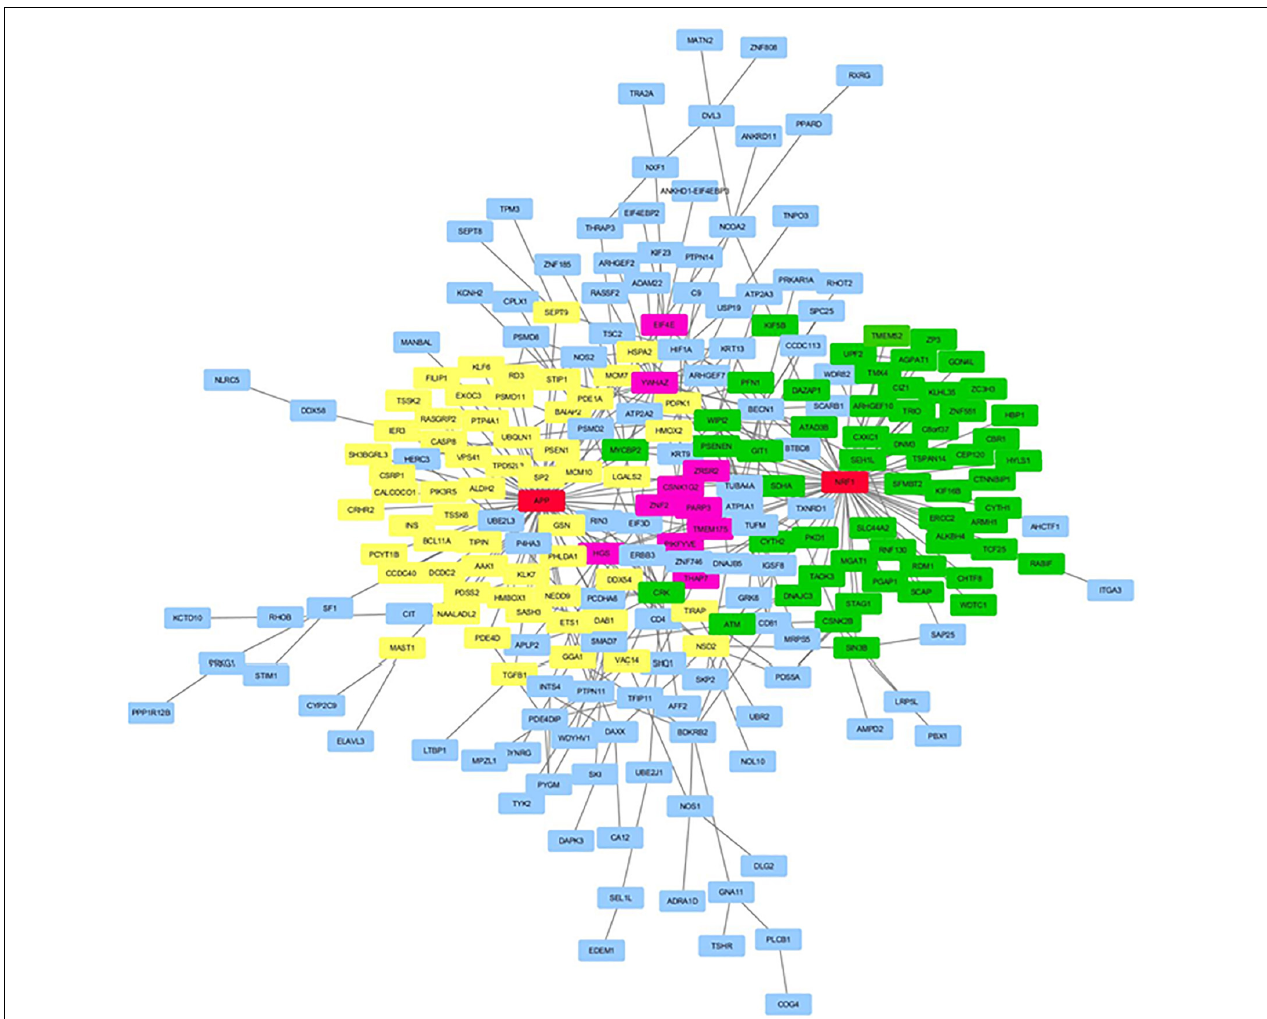
FIGURE 2 | The key network identified by the unsupervised de novo pathway enrichment analysis for the 532-gene overlap. The exception nodes are highlighted in red, while the genes from the 532-gene overlap are highlighted in yellow (the genes directly connected to APP ), green (the genes directly connected to NRF1 ), pink (genes directly connected to APP and NRF1 ), or blue (genes not directly connected to APP or NRF1